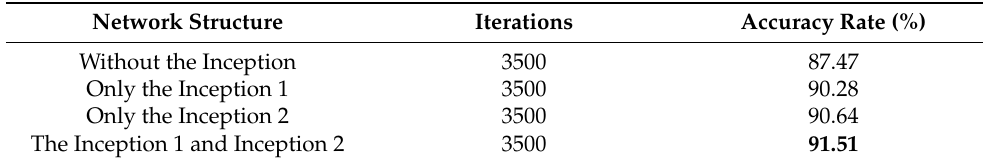
Table 1. Performance evaluation of inception